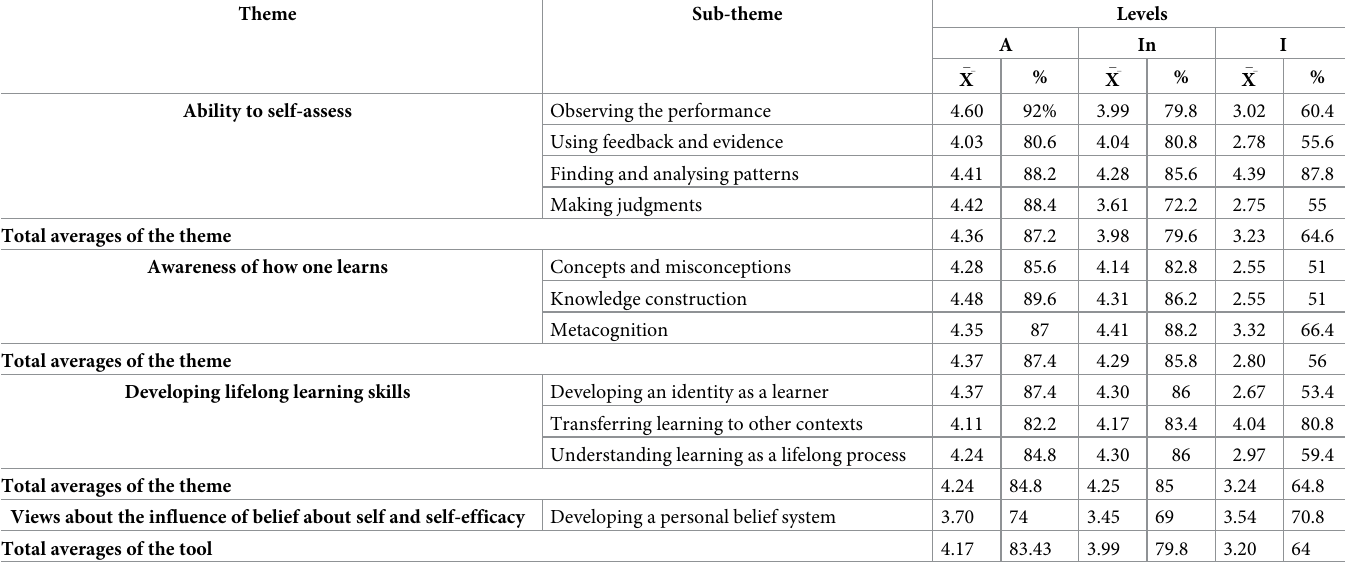
Table 5. Mean results for each of the three levels for the four skills and the whole